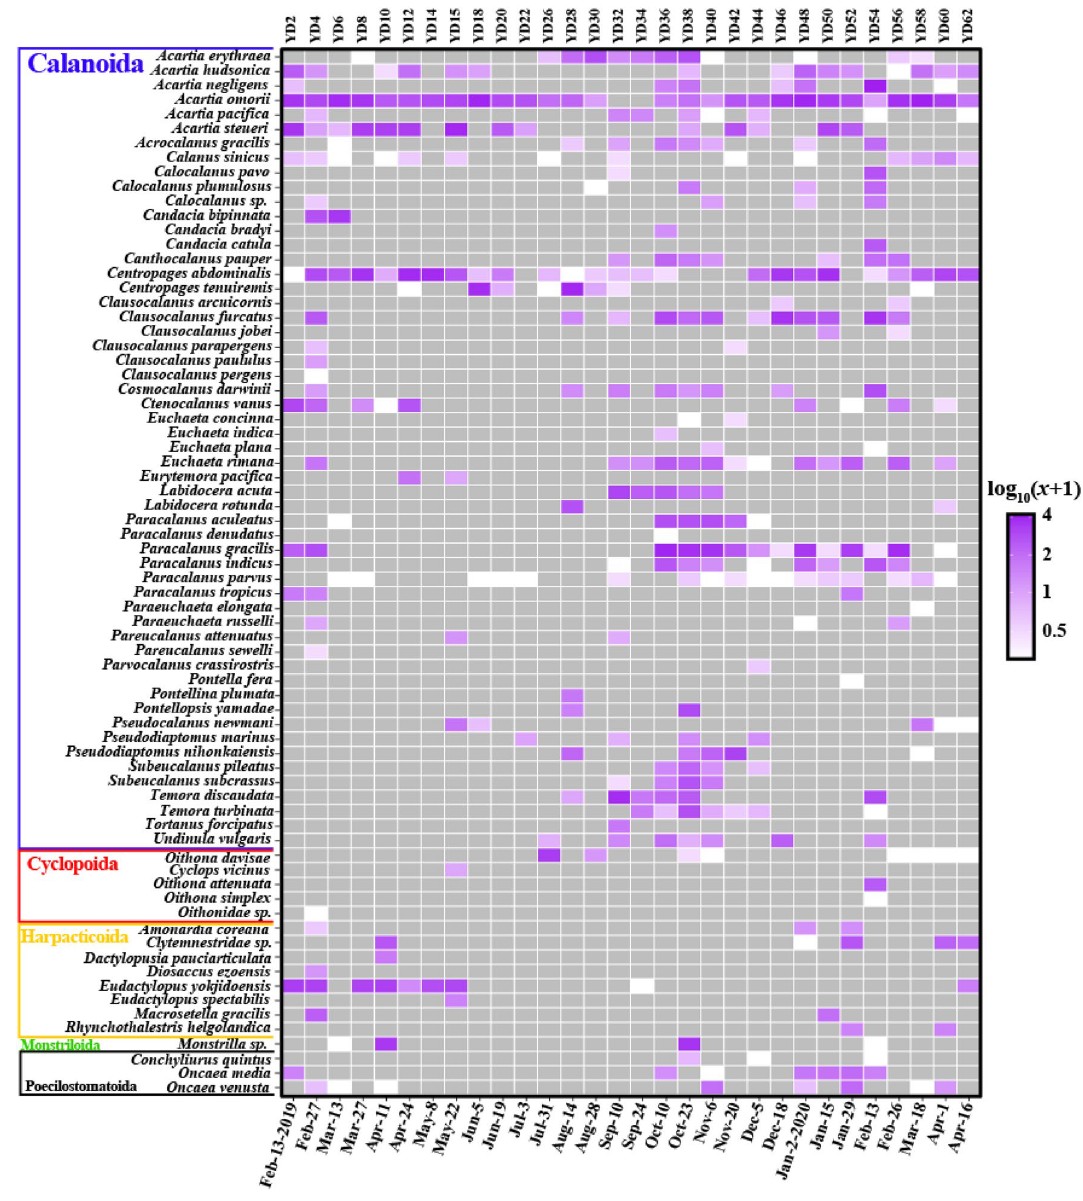
(v4.0.3, https:// www.R- proje ct.